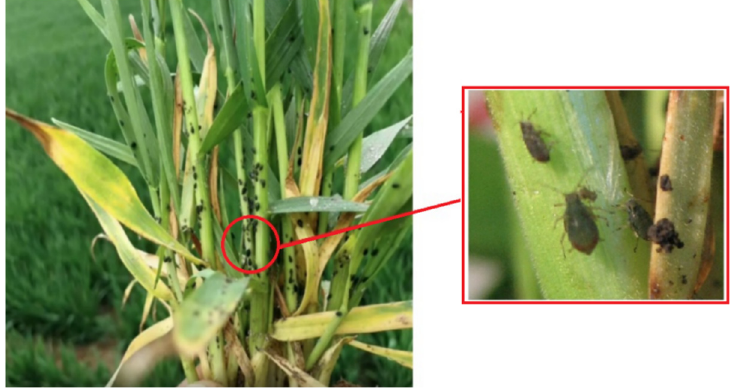
Figure 4. Distribution of wheat aphids.